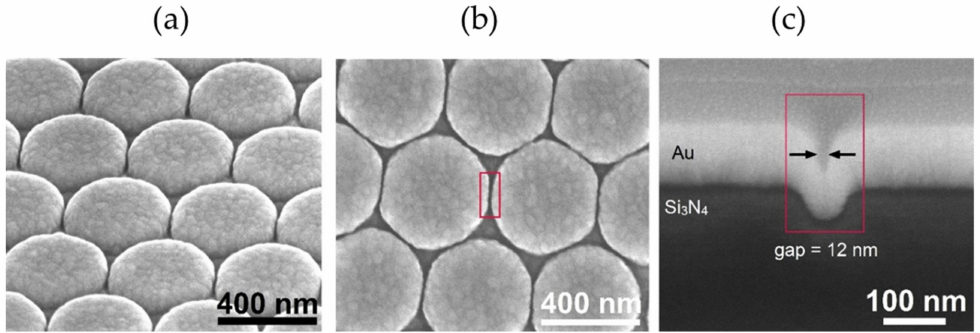
Figure 4. Scanning electron microscope images of gold nanodomes. ( a ) Tilted view. ( b ) Top-down view. ( c ) Cross-section of a nanodome-patterned chip with a 12 nm wide gap between nanodomes.